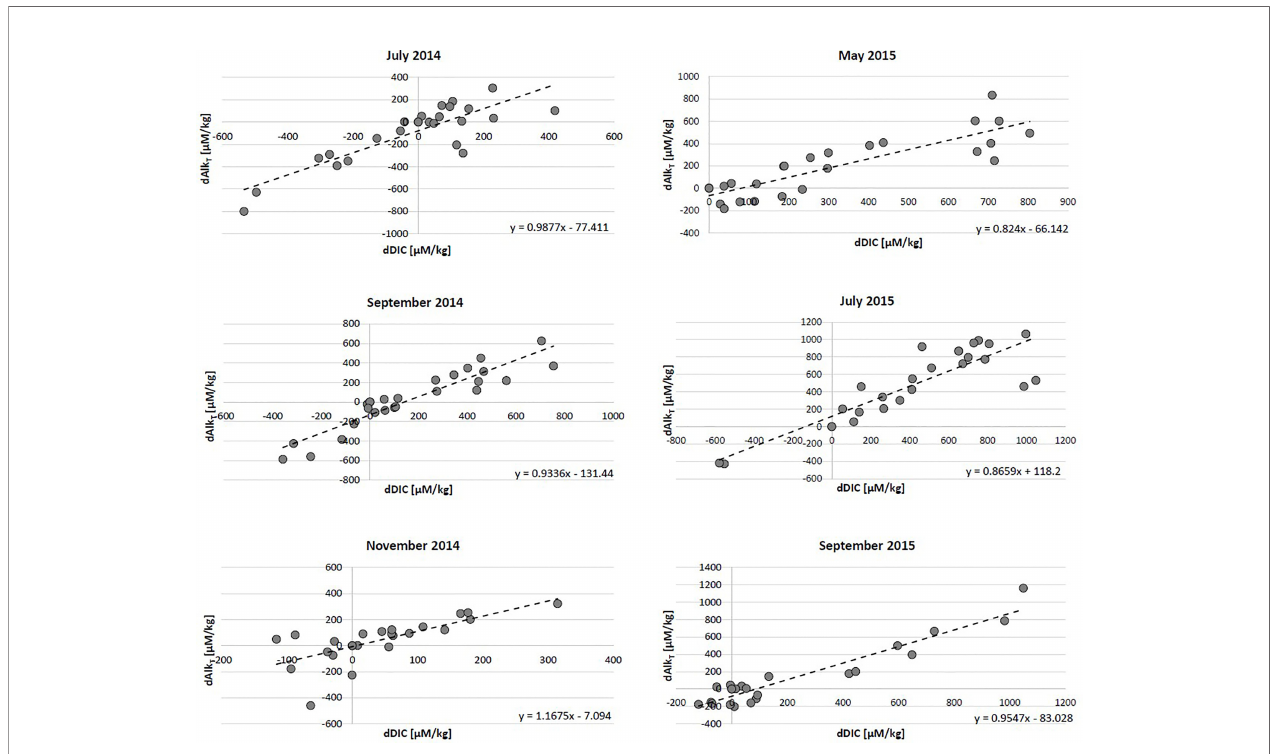
FIGURE 6 | Excess DIC (dDIC) and excess Alk T (dAlk T ). The linear slope (dotted line) and the equation is displayed for each month. All months display near 1 slopes, despite active aerobic